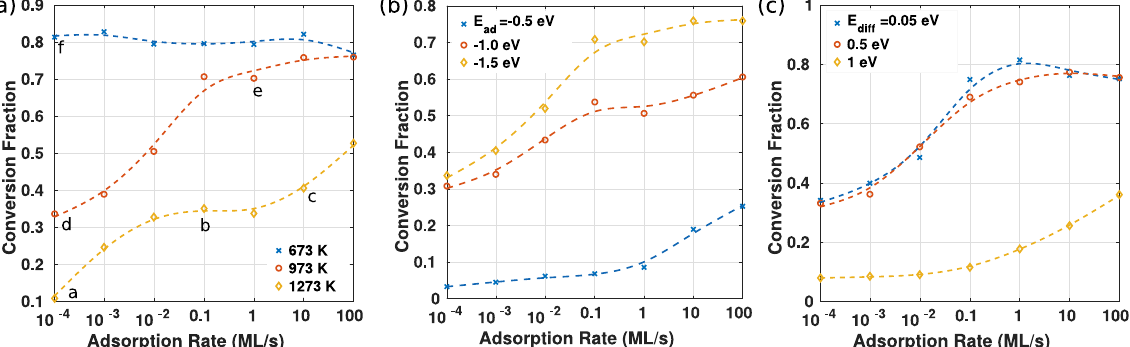
Figure 3. The conversion fraction, represented by the domains’ growth rate in monolayers per second divided by the adsorption rate (also in ML/s), as a function of the adsorption rate, under three different ( a ) substrate temperatures, ( b ) adsorption energies, and ( c ) substrate diffusion energy barriers. The resulting domain morphology under the conditions labeled in Fig. 3a are shown in Fig. 4.